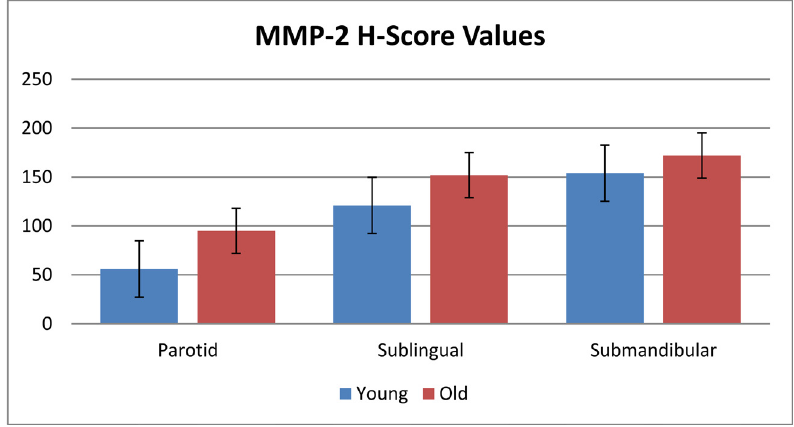
Figure 6- H-score of MMP-2 immunoreactivity in major salivary gland of young and old